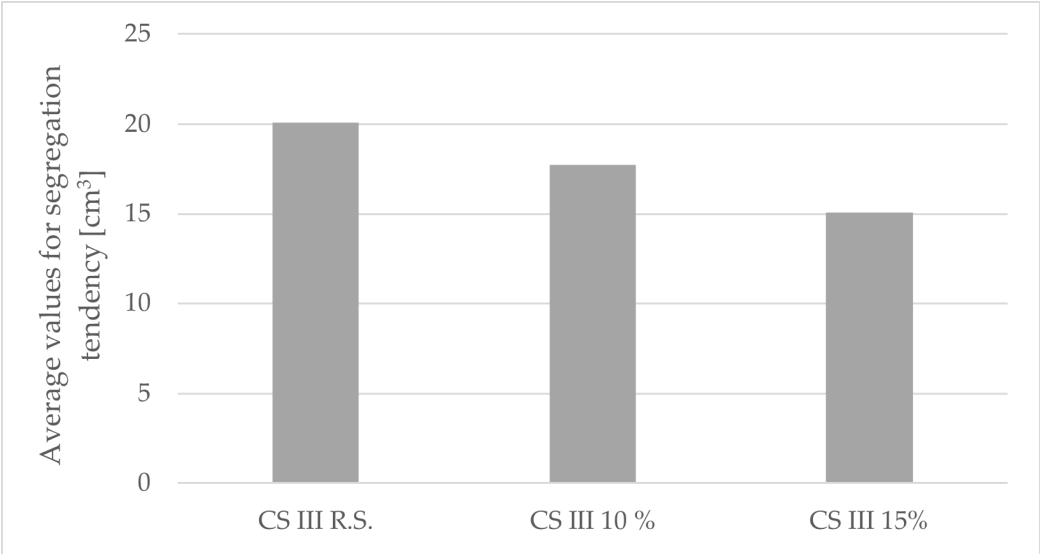
Figure 13. Segregation tendency depending on the percentage of dislocated aggregates.